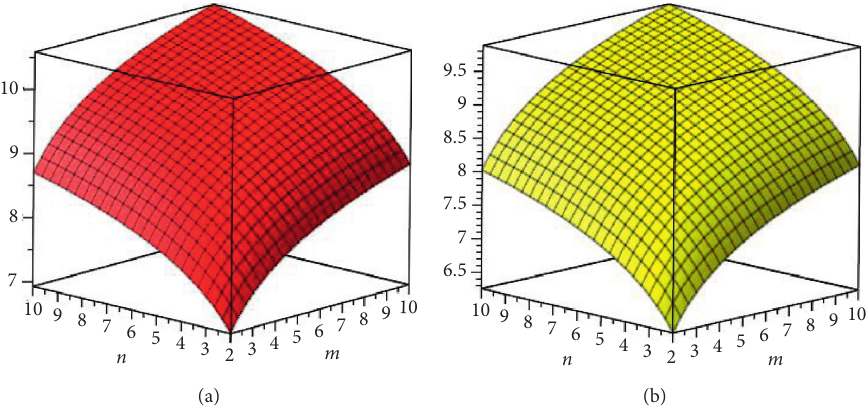
Figure 9: (a) The hyper-Zagreb entropy; (b) the forgotten